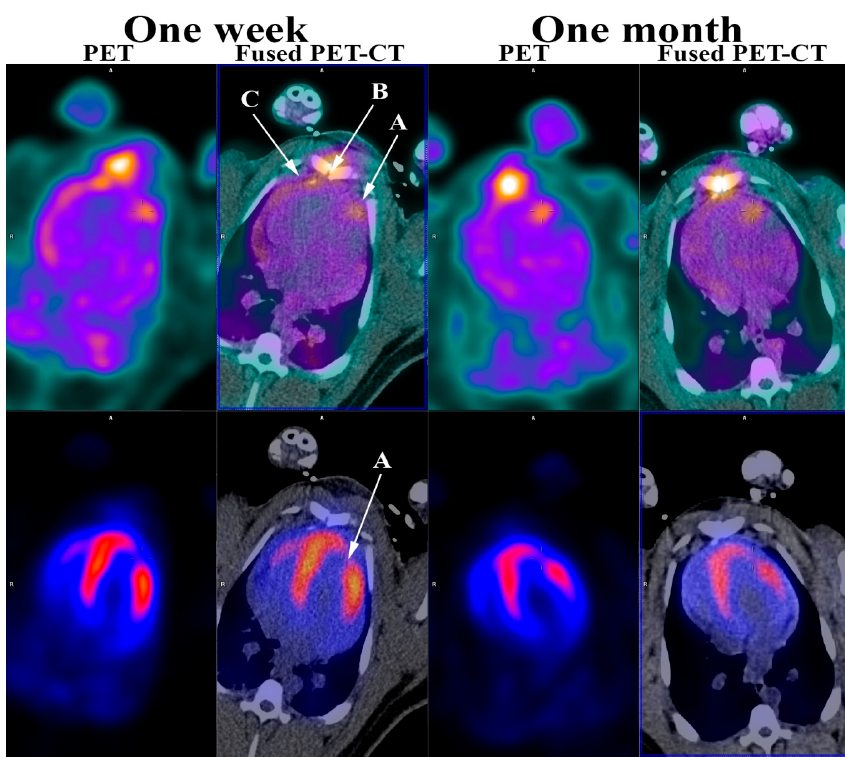
Figure 2. RGD (top row) and 82 Rb stress PET (bottom row) one week and one month after induced myocardial infarction. ( A ) Myocardial infarction; ( B ) Sternotomy; ( C ) Pericardium. As shown, the 82 Rb stress PET (bottom row) showed a myocardial perfusion defect in the anterior wall of the left ventricle myocardium one week and one month after induced myocardial infarction confirming a myocardial infarction corresponding to an area supplied by the ligated branch from LAD. This myocardial perfusion defect was also present at rest (not shown). Furthermore, the RGD PET (top row) showed RGD uptake in the infarcted myocardium one week and one month following myocardial infarction. In addition, RGD PET showed RGD uptake in the sternum after sternotomy and pericardium, most likely due to the opening as part of the infarct induction procedure. As previously mentioned, most of the previous work in angiogenesis imaging have been done in smaller animals. The minipig heart and the human heart are very much alike, which makes the findings in this study even more encouraging and adds to the few, mostly very small, studies performed in